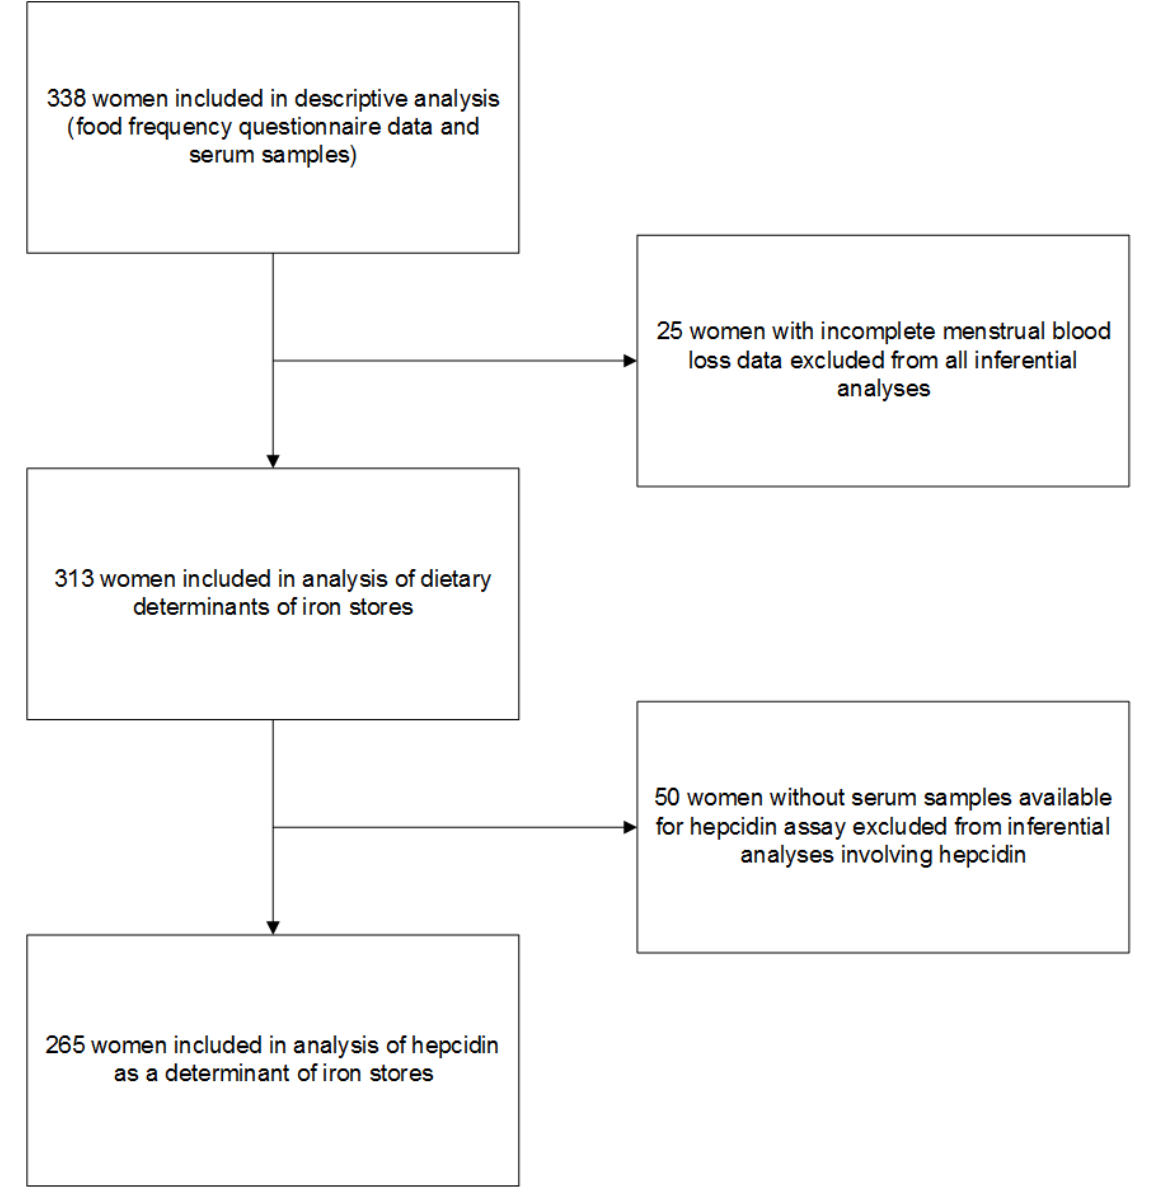
Figure 1. Study flow diagram and inclusion of women in analyses.